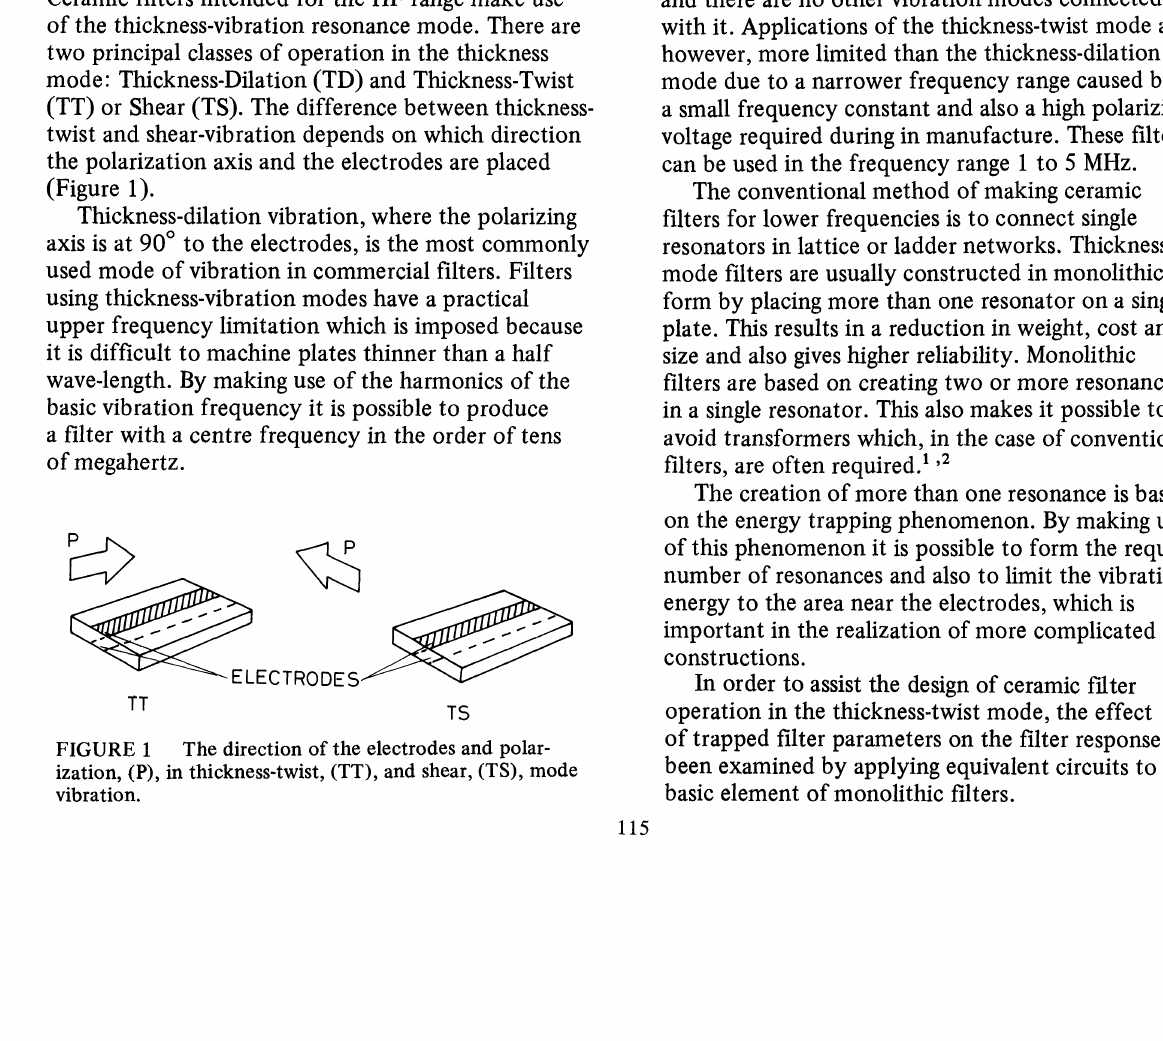
The direction of the electrodes and polar- ization, (P), in thickness-twist, (TT), and shear, (TS), mode